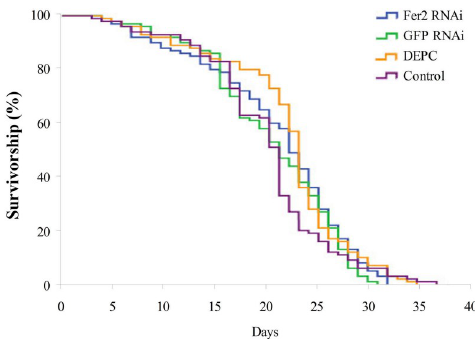
Fig 2. The survivorship of worker bees in the ferritin2 RNAi, the GFP RNAi, the DEPC water, and the control. Fer2 RNAi, feeding with ferritin2 dsRNA. GFP RNAi, feeding with GFP dsRNA. DEPC, feeding with DEPC water. Control, no additional feeding ( n = 200; P = 0.149). P -value was calculated using the log-rank (Mantel-Cox) method.